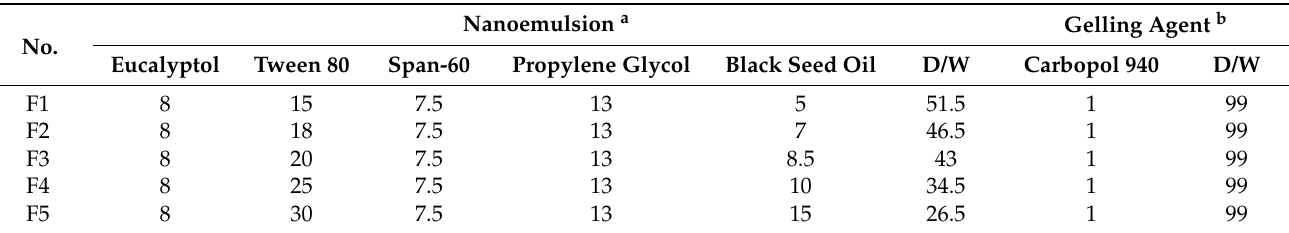
Table 1. Various compositions of nanoemulgels w / w